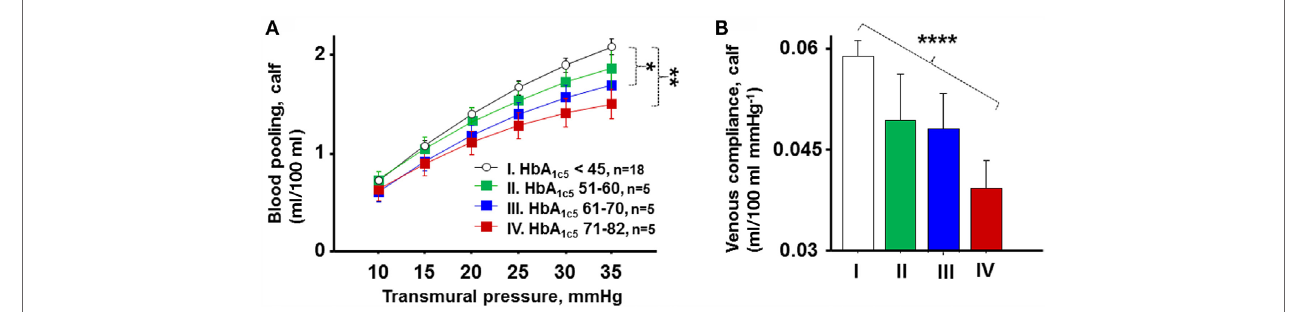
FigUre 3 | (a) Calf blood pooling divided into four groups based on HbA 1c5 denoted normal (I, white circles, n = 18), mild (II, green boxes, n = 5), moderate (III, blue boxes, n = 5), and poor (IV, red boxes, n = 5). Blood pooling was progressively reduced in groups with increasing HbA 1c5 ( P = 0.005). Women with normal HbA 1c5 had significantly greater blood pooling during LBNP of 44 mmHg than women with moderate and severe HbA 1c5 ( P = 0.02 and P = 0.001, respectively). (B) Corresponding mean venous compliance during transmural pressure of 10–35 mmHg in analogous groups (I–IV). A progressive reduction in venous compliance with increasing HbA 1c5 throughout the studied pressure range of 10–35 mmHg was seen ( P <